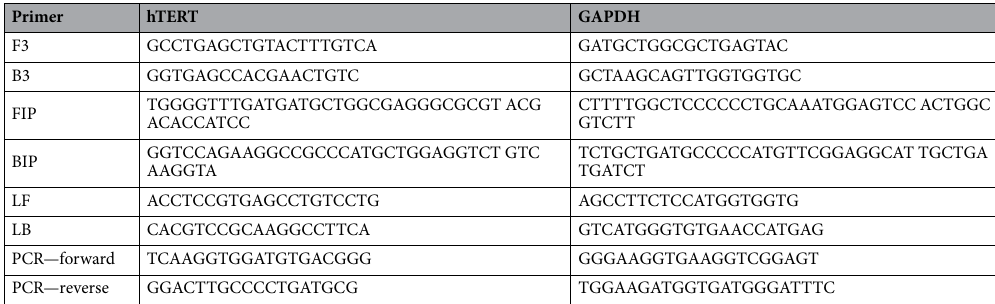
Table 2. LAMP and PCR primer sequences for hTERT and GAPDH mRNA, in 5